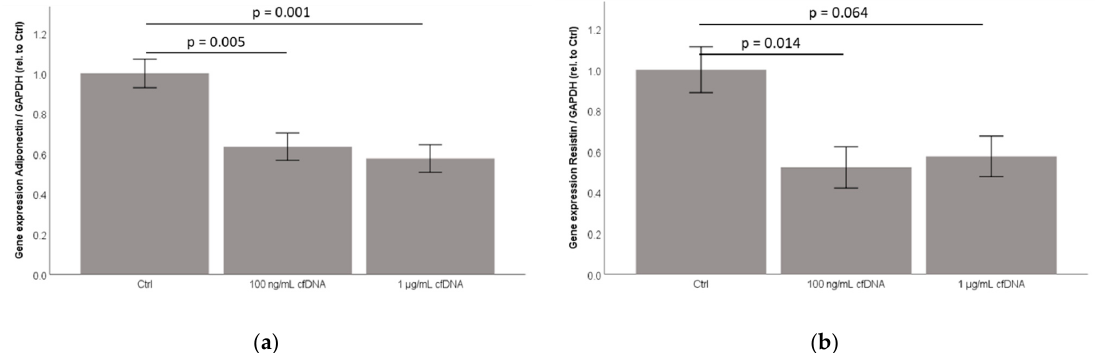
Figure A4. Cell-free nucleic acids (cfDNA) reduce both adiponectin and resistin mRNA levels in 3T3-L1 adipocytes in vitro. Mature 3T3-L1 adipocytes ( n = 17–18 wells each) were treated with different doses of cfDNA (100 ng/mL, 1 µg/mL) generated from TNF-exposed 3T3-L1 adipocytes as described in the Materials and Methods section for 18 h. After isolation of mRNA applying the RNeasy ® Mini Kit (Qiagen, Hilden, Germany), gene expression levels of murine adiponectin and resistin were quantified by reverse transcription and real-time PCR (RT-PCR) of the corresponding cDNA and normalized to GAPDH, as described in the Materials and Methods section. cfDNA reduced both ( a ) adiponectin and ( b ) resistin mRNA levels.